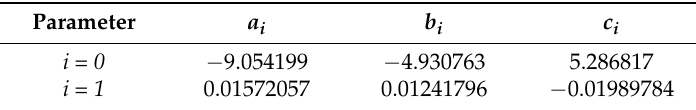
Table 1. Optimized coefficients for the R-K model with temperature dependent terms shown in